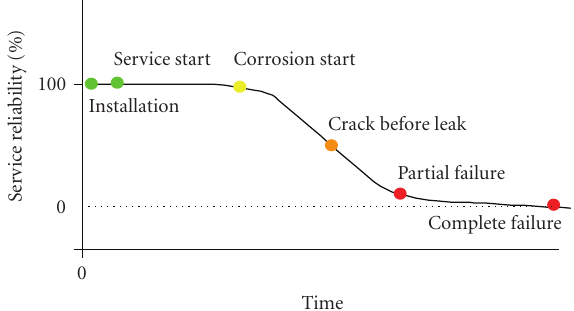
Figure 1: Pipe failure development. (Adapted from